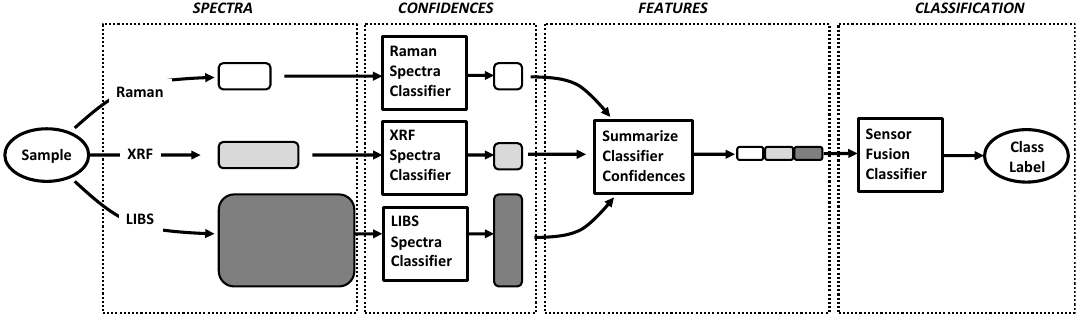
Figure 1. Flow chart of the process used for analyzer data fusion. The three instruments collected spectra (Figure 2) from multiple locations on each soil pellet. These spectra are first classified using analyzer-specific classifiers, that output a set of confidence values that each spectrum belongs to each class. Then, the confidences from each analyzer-specific classifier are averaged and concatenated to generate a single vector for the sample. Finally, this vector is used as the input to the final data fusion classifier and a class label for the sample is generated.